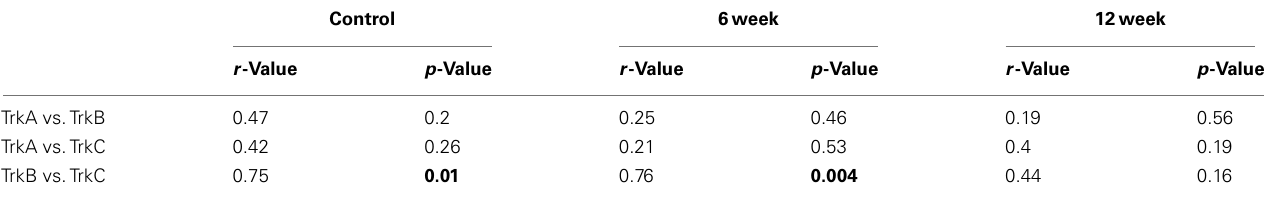
Table 3 | Correlations between expression of mRNA for trk receptors in spinal cord.